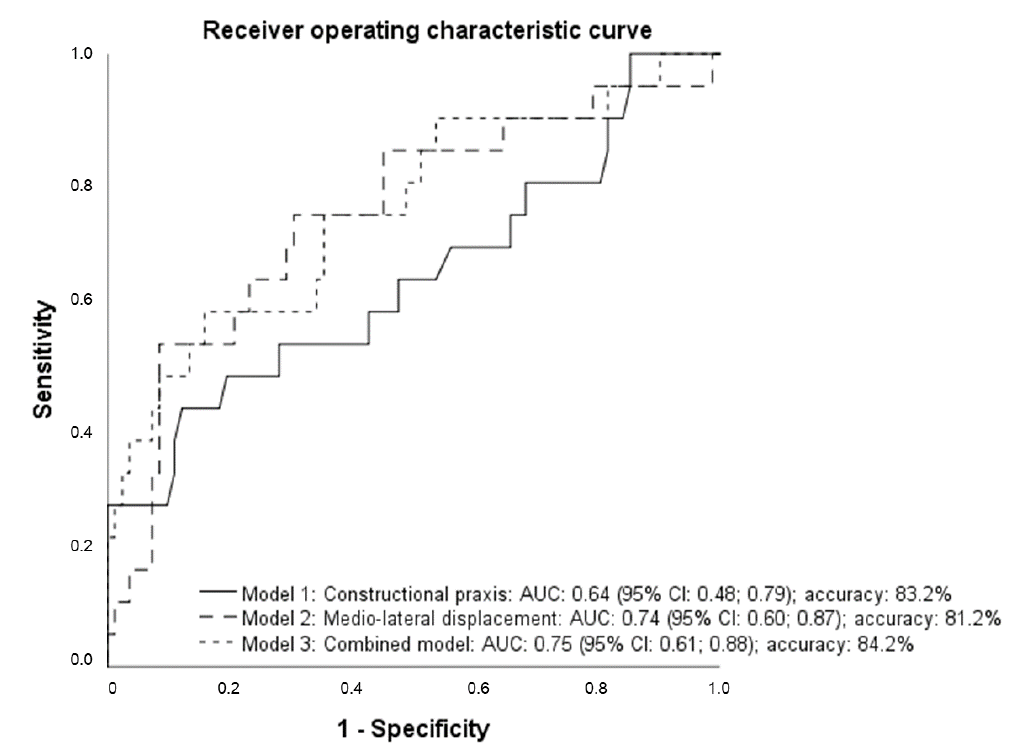
Figure 1. Receiver operating characteristic curve for the two individual and the combined predictors for in-hospital falls in patients with dementia. Presented are receiver operating curves of different models for predicting future in-hospital falls in PwD: Model 1 used ‘constructional praxis’ (AUC: 0.64), model 2 used ‘medio-lateral displacement’ (AUC: 0.74), and model 3 combined these two variables to a combined model (0.75).